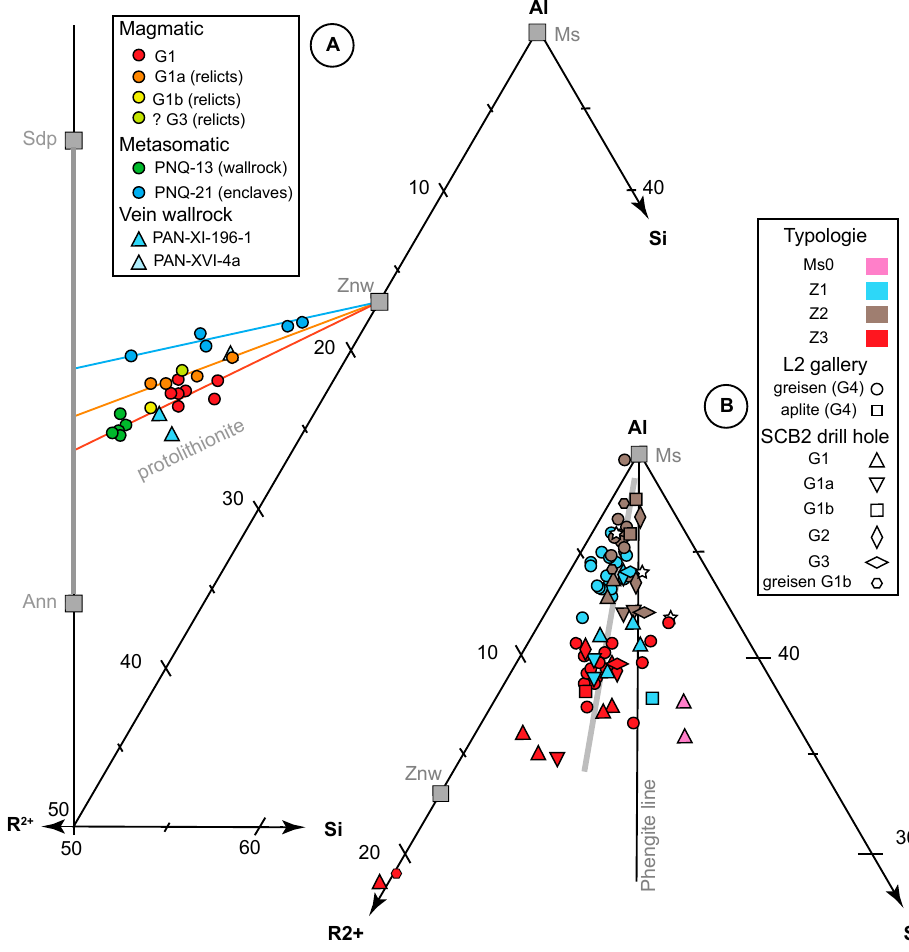
Figure 19. Mica chemistry in the Al-R 2 + -Si diagram [51]. ( A ) Trioctahedral micas; ( B ) Dioctahedral micas. Ms = muscovite, Sdp = siderophyllite, Ann = annite; Znw = zinnwaldite. Legend of symbols, see text.